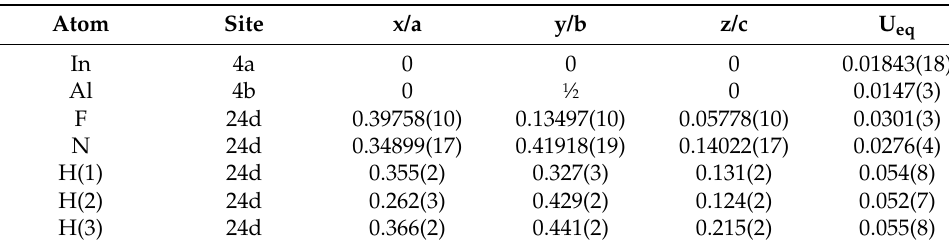
Table 6. Fractional atomic coordinates and isotropic displacement parameters (in 10 4 pm 2 ) of